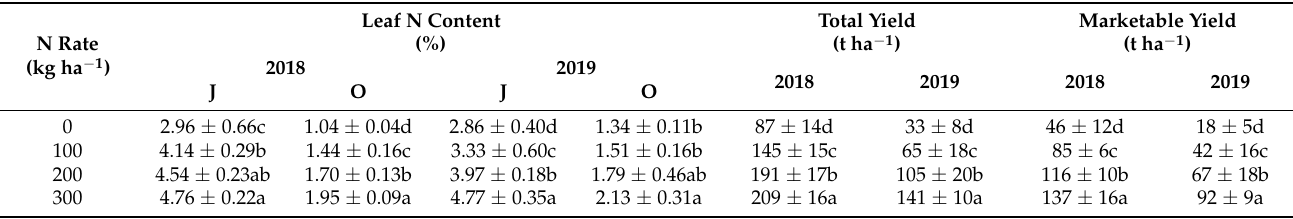
Table 1. Mean values ± SD ( n = 6) of cabbage leaf N content determined by the Kjeldahl method (J-July, O-October) and total and marketable cabbage yields as function of N rate 1